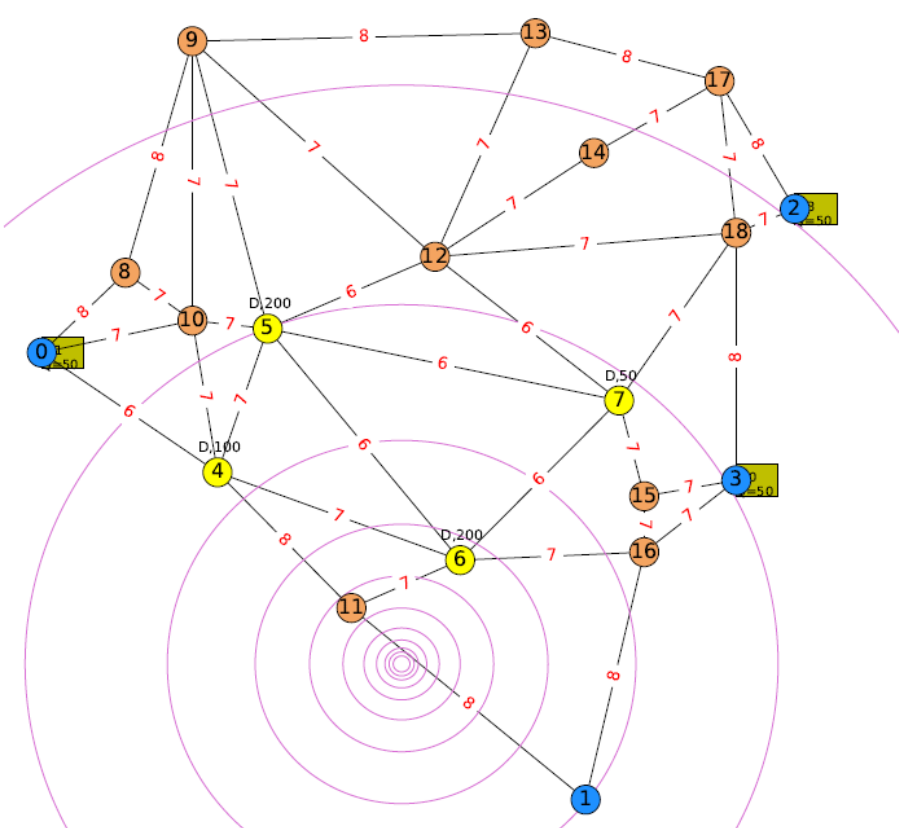
Figure A2. Road Network for Instance